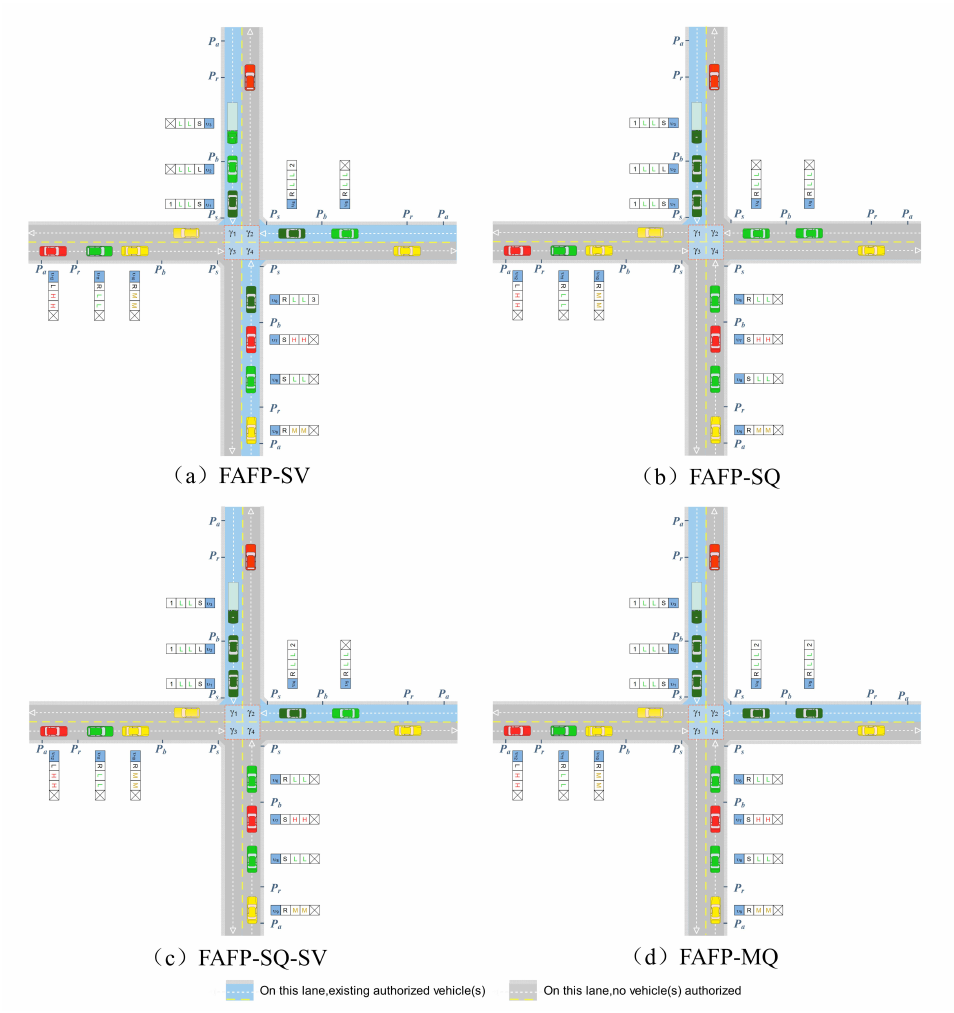
Figure 6. Traffic Situations with Four FAFP-based Cooperation Policies. ( a ) FAFP-SV. ( b ) FAFP-SQ. ( c ) FAFP-SQ-SV. ( d )